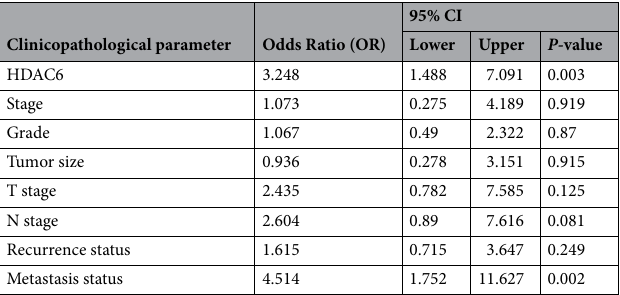
Table 3. Multivariate Cox regression analysis of overall survival for patients with OSCC. CI confidence